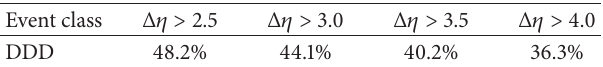
Table 6: The fraction of DDD events which can be tagged as SDD events in the limited rapidity range |𝜂| < 5.2 . Gap is defined as edge gap.